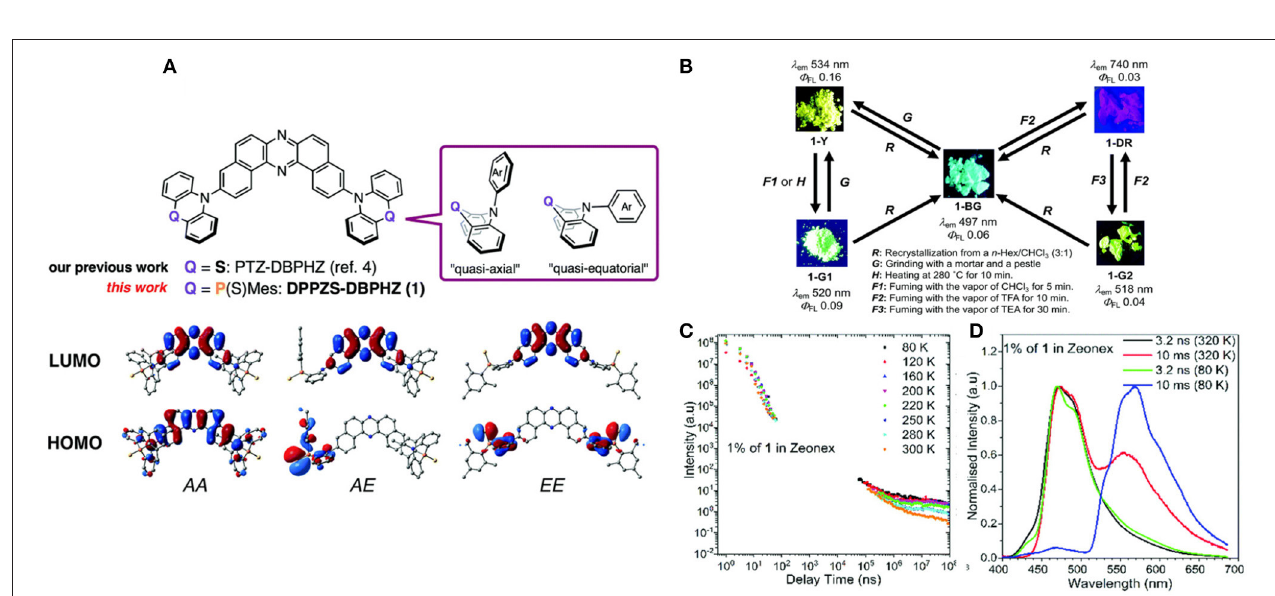
FIGURE 12 | (A) Chemical structures of investigated molecules and the frontier orbitals of the conformers of 1. (B) Summary of the Mechanoluminescence property of 1 (C) Emission intensity at various temperatures of DPPZS-DBPHZ against delay time (D) PL spectra (Normalized) of 1 at various temperatures. Reproduced with permission from Takeda et al. (2018). Copyright © The Royal Society of